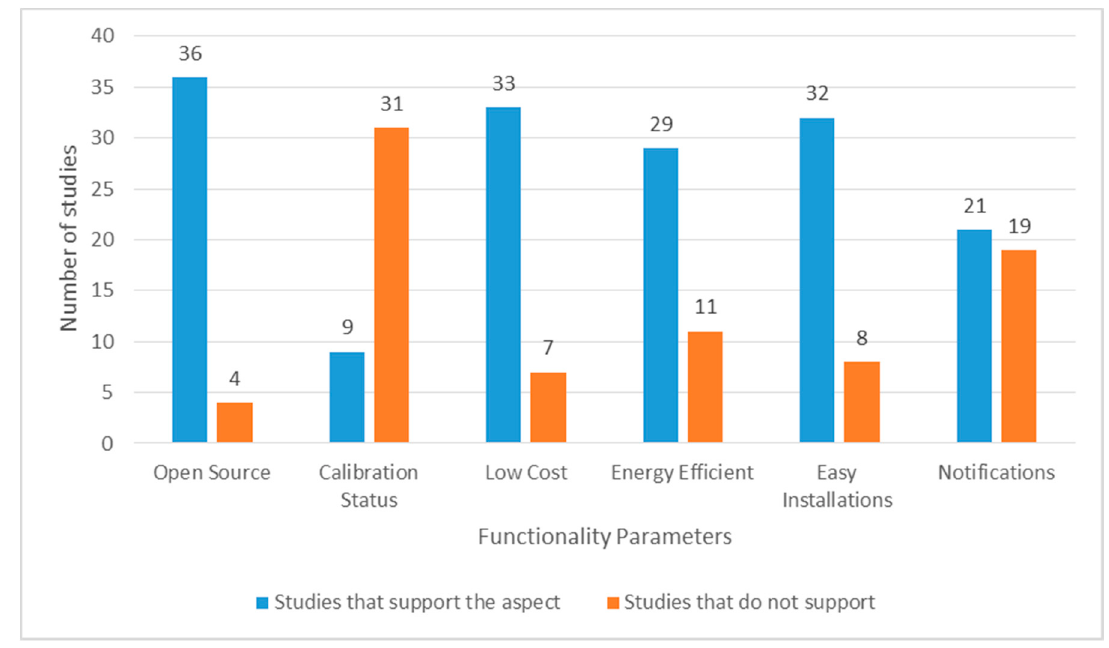
Figure 5. Functionality details of included studies.